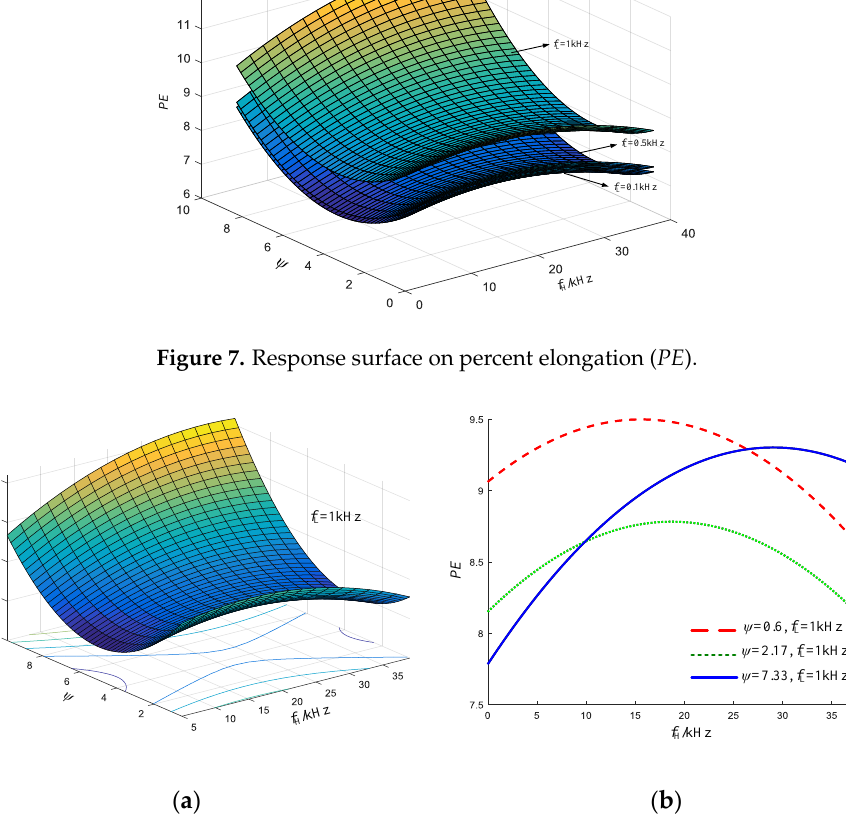
Figure 8. Contour plot of surface on percent elongation ( PE ): ( a ) contour plot of surface that f L is 1 kHz; ( b ) interaction of f H and ψ.